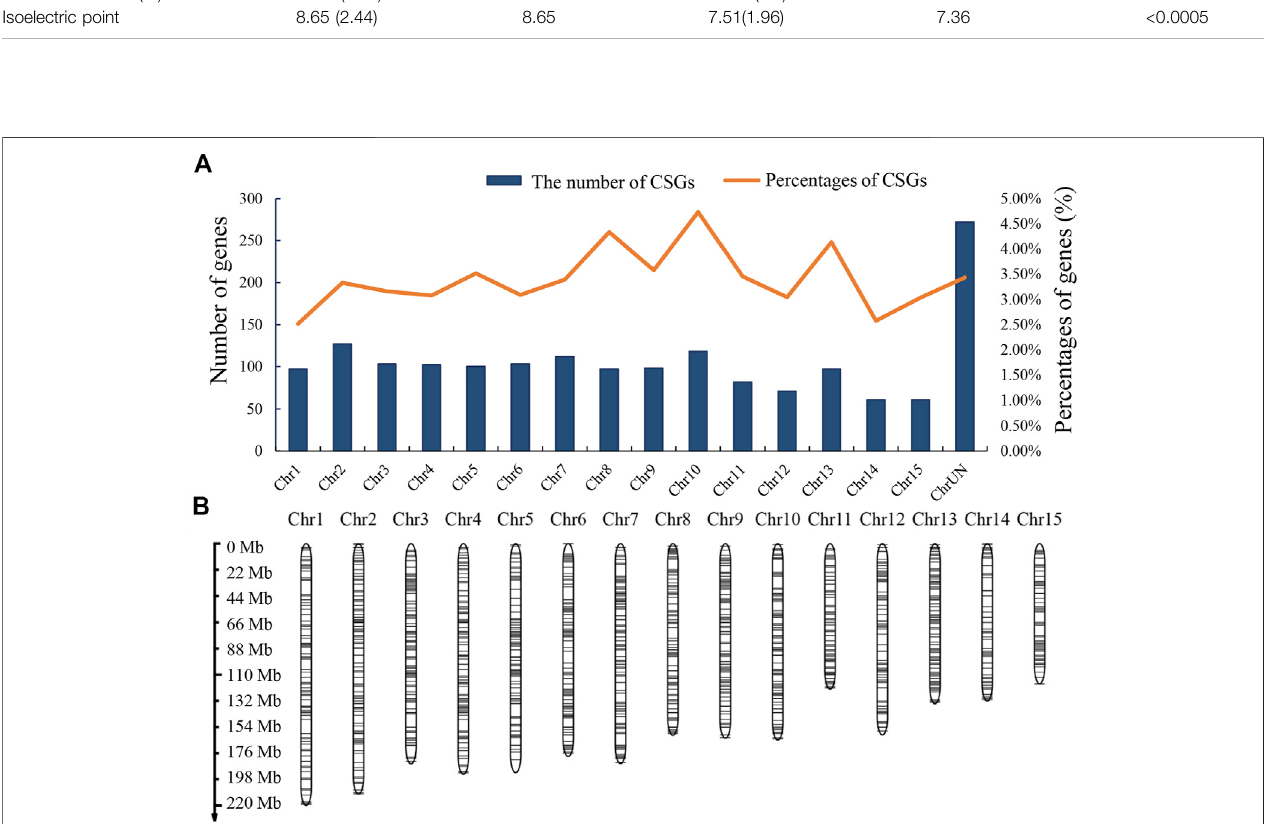
Frontiers in Genetics |